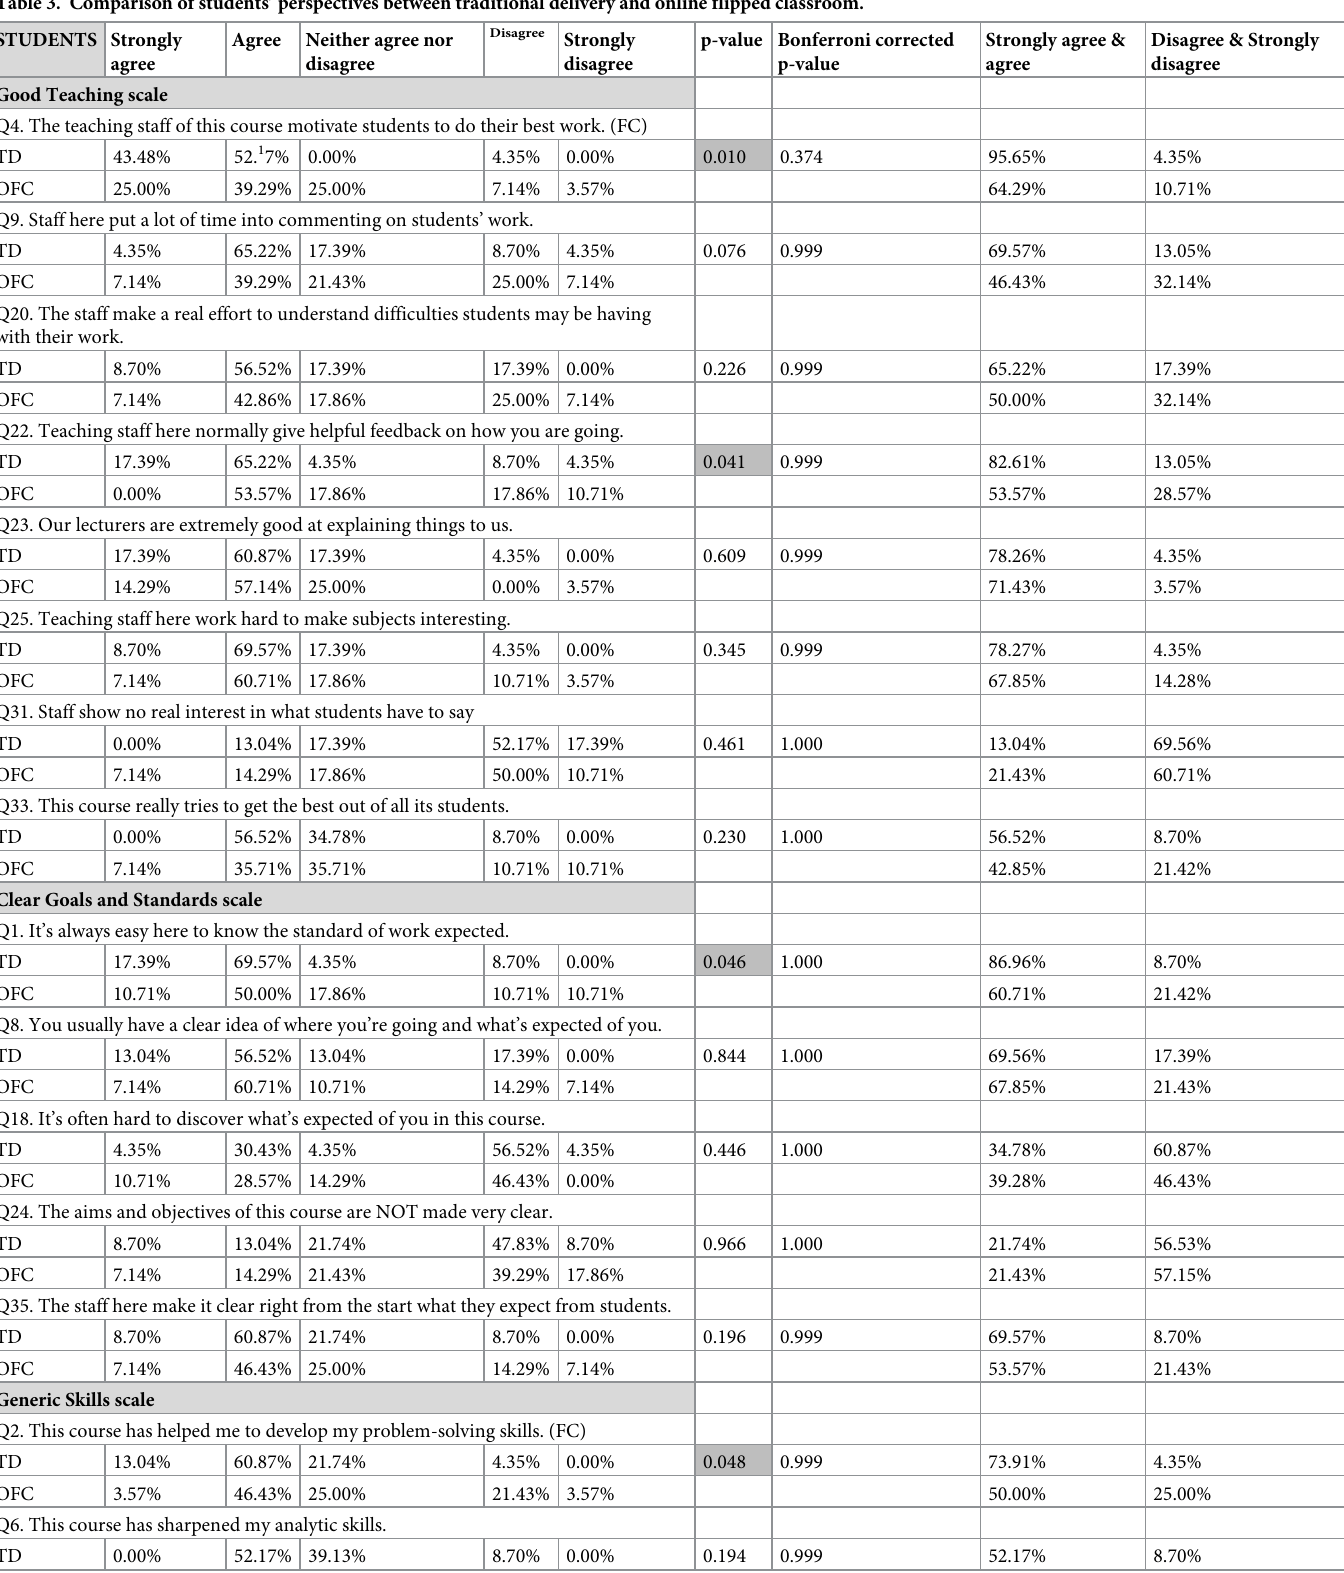
Disagree Strongly p-value Bonferroni corrected disagree p-value